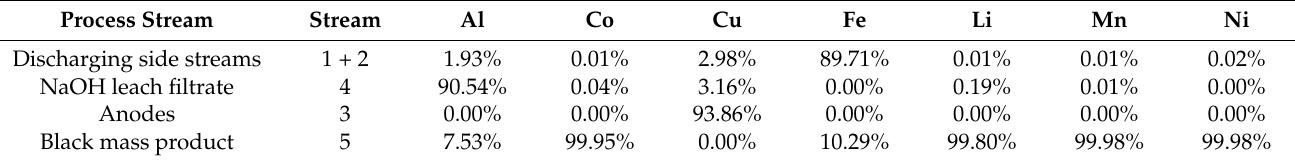
Table 4. Percentage of the metals reporting to the process streams from the LIB